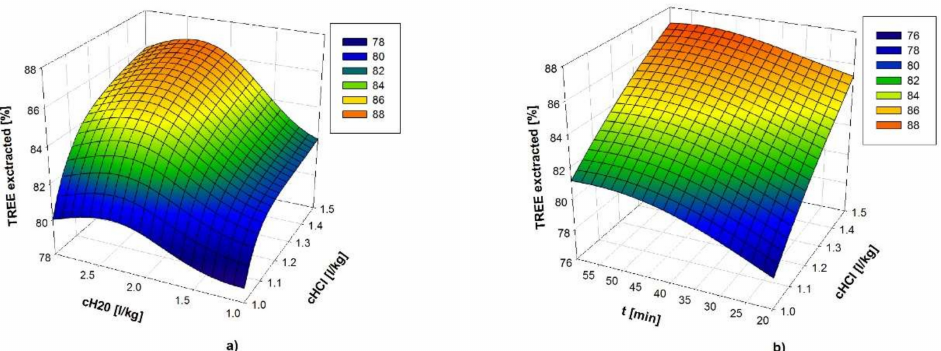
Figure 13. Final ANN data table numerical model for TREE extraction: ( a ) T = 20 ◦ C = const. , t = 60 min. = const. ; ( b ) T = 20 ◦ C = const. , c H 2 O = 1.5 L/kg = const